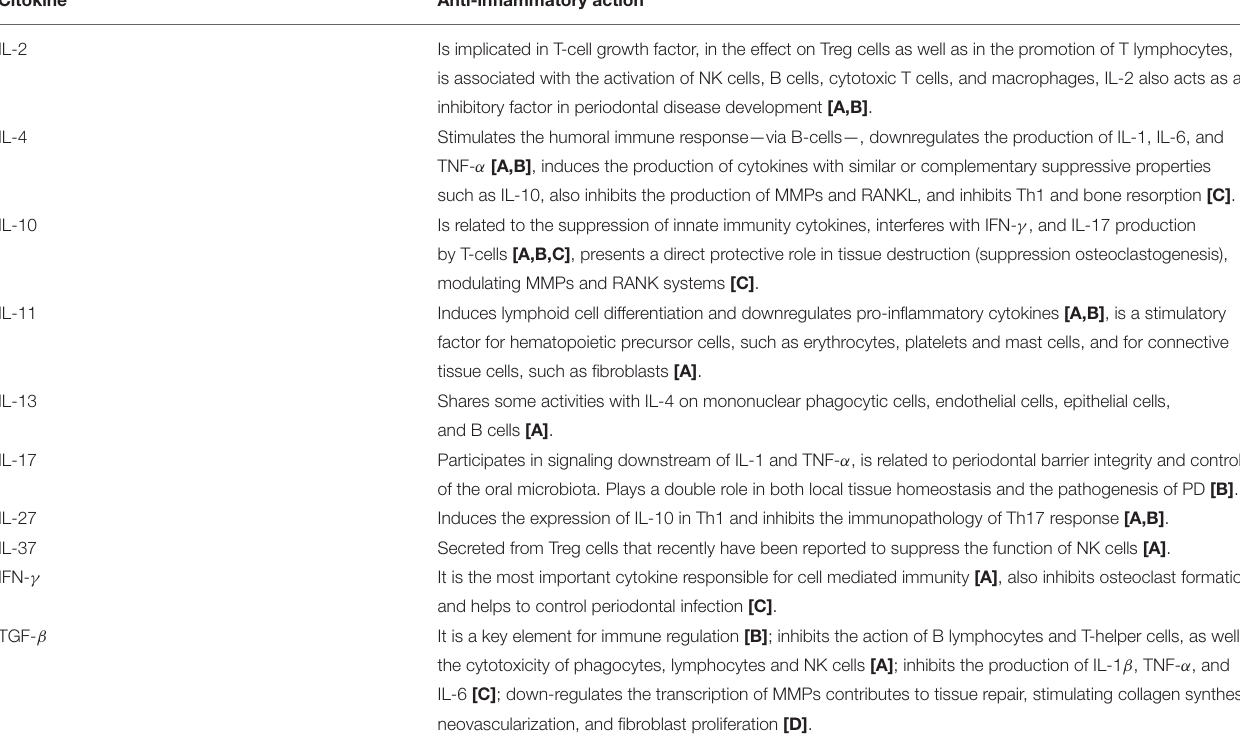
TABLE 2 | Brief overview of anti-inflammatory cytokines involved in periodontal disease. Citokine Anti-inflammatory